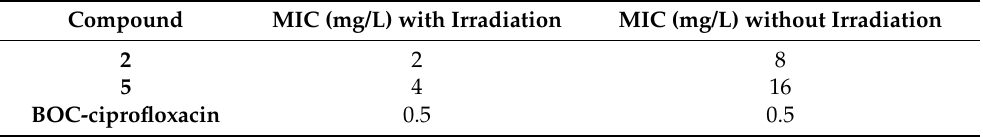
Table 3. MIC values for the deprotected forms obtained in the presence of E. coli ATCC 25922 with and without irradiation. Green light (100 W, 520 nm for compound 2 ) or red light (50 W, 625 nm for compound 5 ) were used for 1